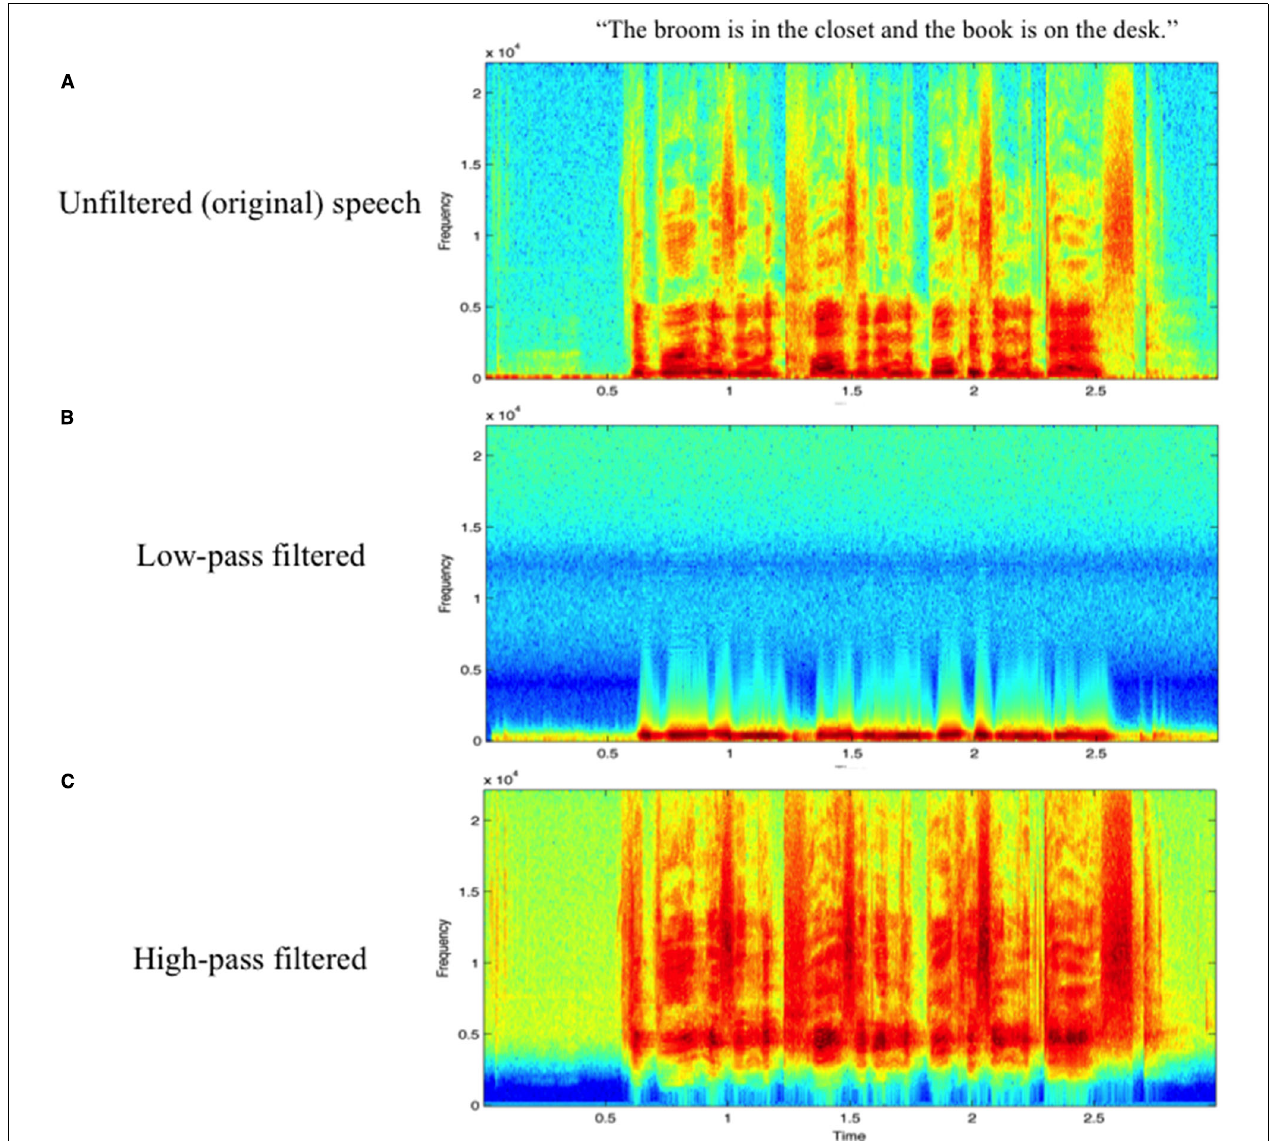
FIGURE 2 | Spectrograms of a representative speech sample in (A) unfiltered, (B) low-pass filtered, and (C) high-pass filtered